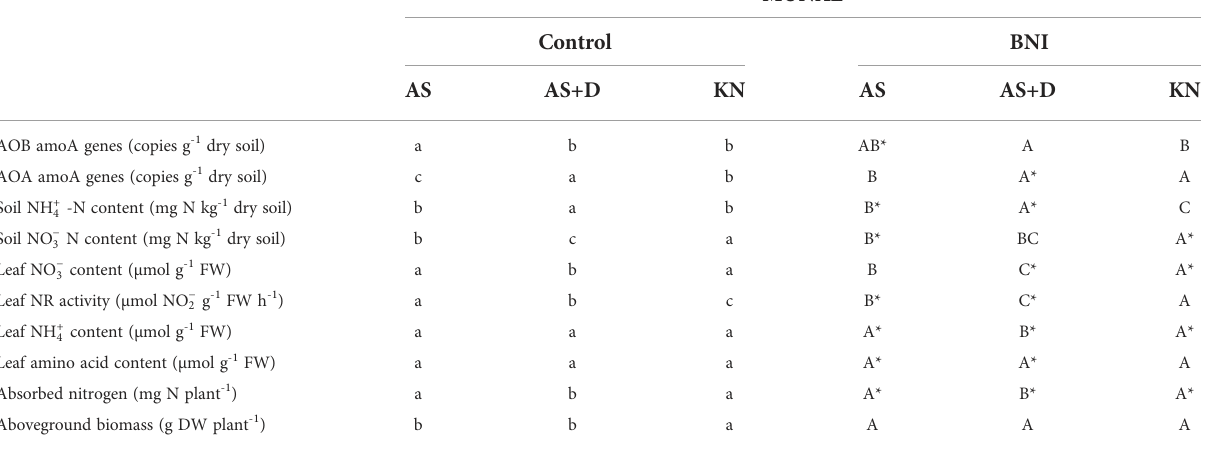
TABLE 4 Statistical analysis of measured parameters in MUNAL Control and